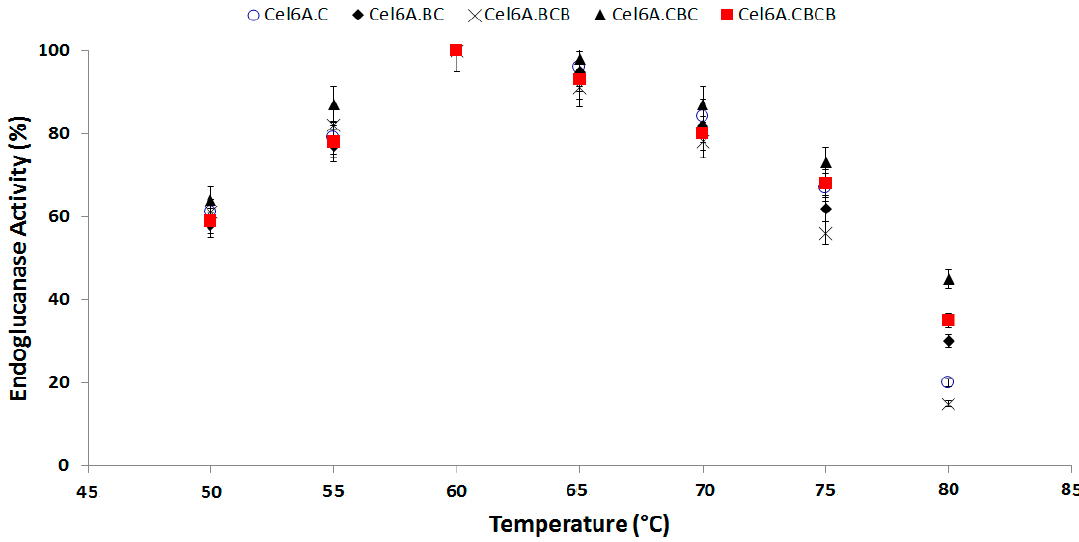
ff ect of Temperature on hydrolytic activity of cel6A variants against Figure 2. Effect of Temperature on hydrolytic activity of Cel6A variants against CMC. Figure 2. E